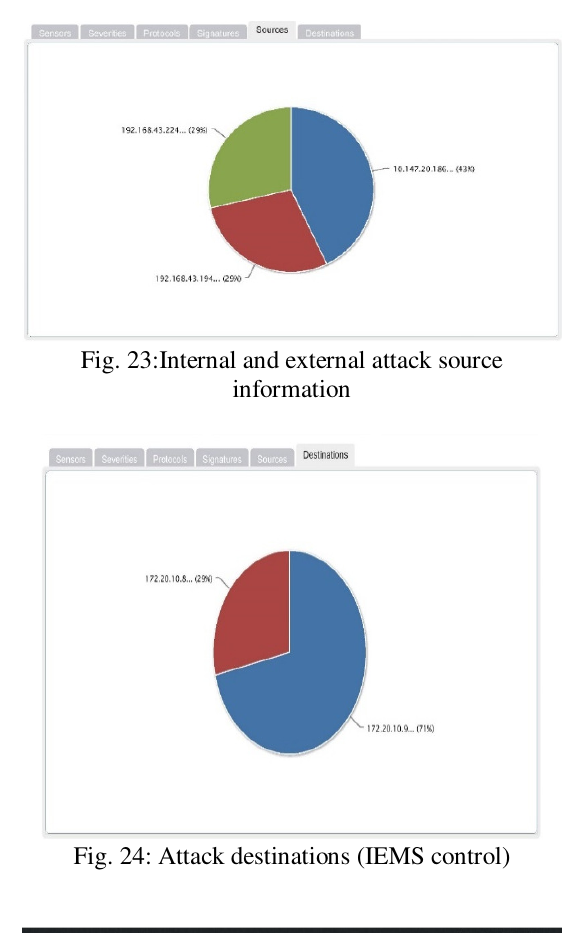
Fig. 24: Attack destinations (IEMS control)